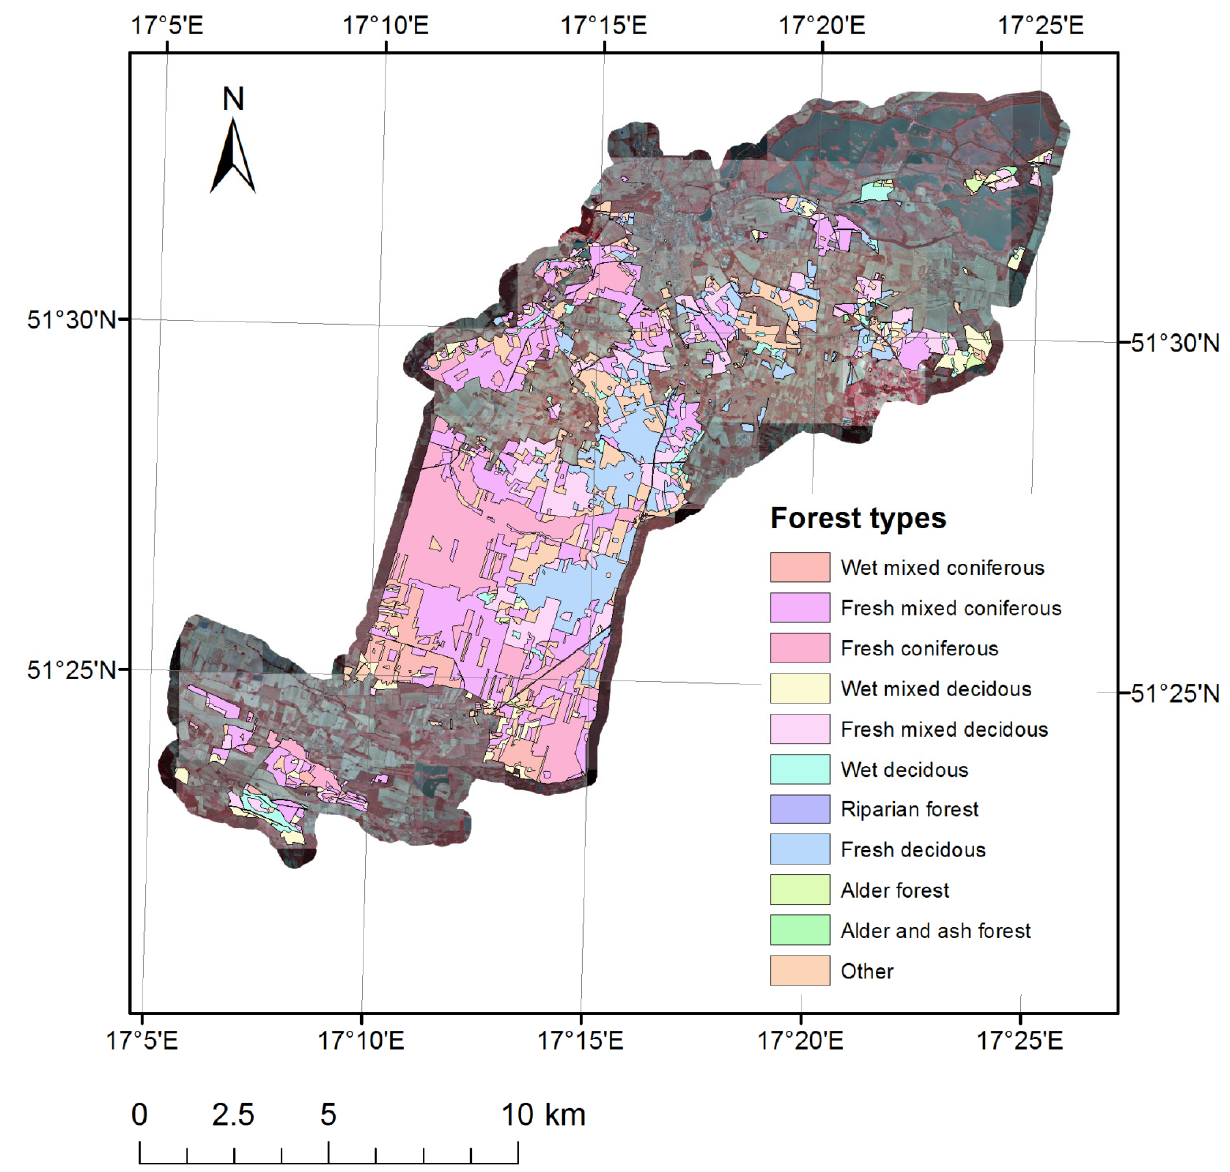
Figure 1. The area of investigation (Forest types and